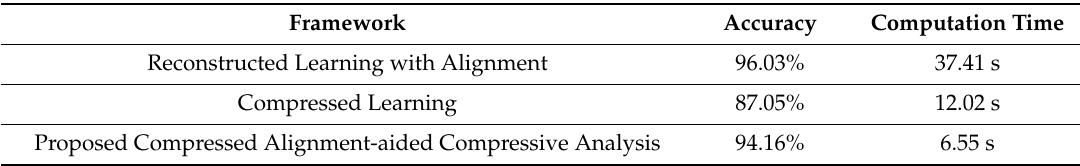
Table 4. Computation time and accuracy of the different algorithm. *